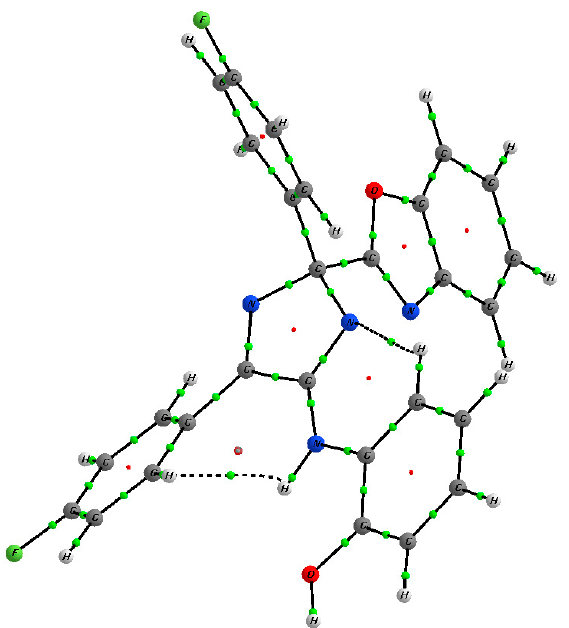
Figure 4. The molecular graph of 10b according to PBE1PBE/def-2-TZVP calculation. The critical points (3, − 1) and (3, +1) are shown by small green and red balls. The bond path for C-H···H-N and C-H···N interactions is shown by dashed lines.